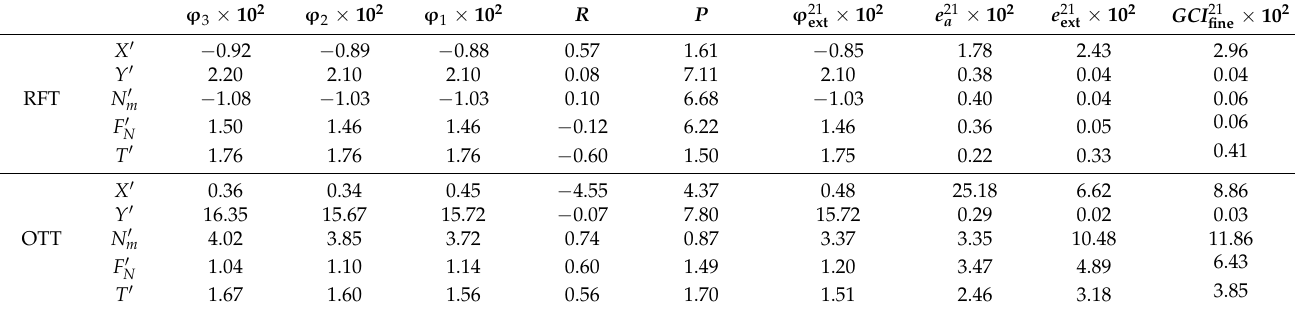
Table 2. The discretization error and uncertainty in spatial convergence study (MRF method).